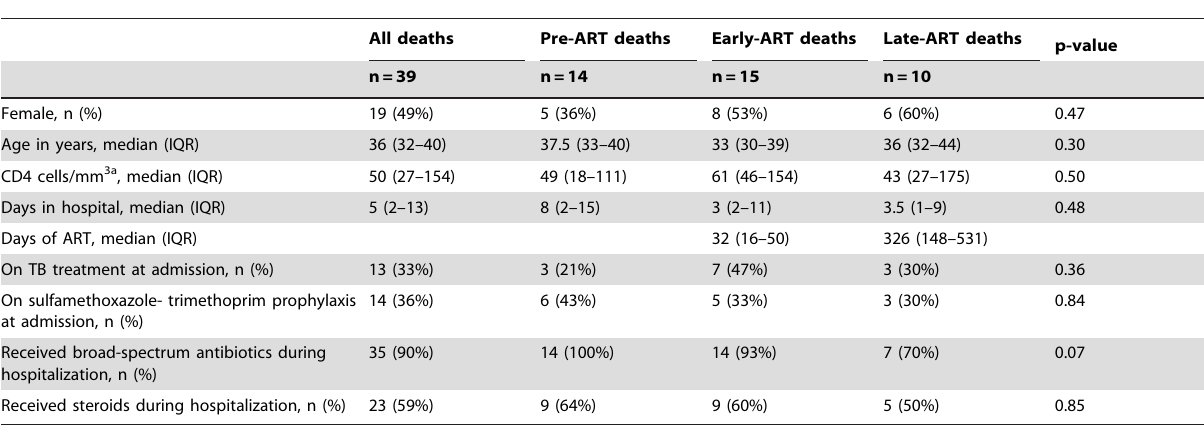
Table 1. Pre-mortem characteristics of the study